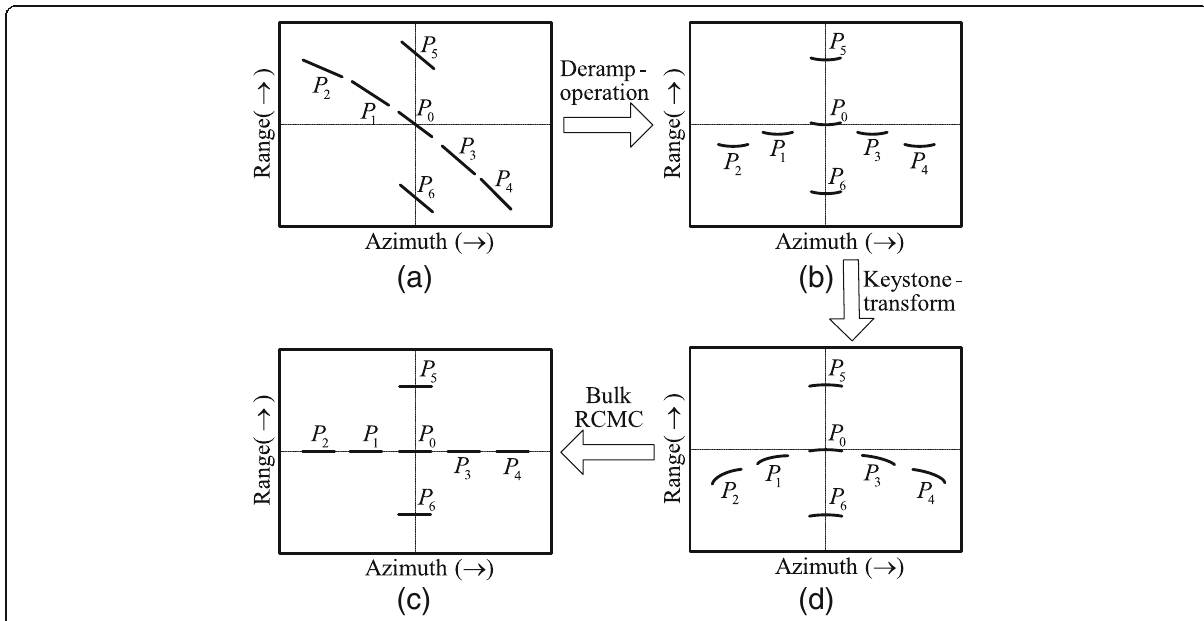
Fig. 4 Steps of RCMC (suppose the range compression has been performed). a Data space. P 0 , P 1 , P 2 , P 3 , and P 4 have the same bistatic slant ranges when azimuth time t =0. P 0 , P 5 , and P 6 are in the same azimuth cell. b Data space after deramp operation. The ramps have been removed, but only the linear RCM of P 0 has been completely removed. c Data space after KT. Linear RCMs of all targets are removed. d Data space after bulk RCMC. RCMs of all targets are removed, and also, their range histories have been shifted into the same range